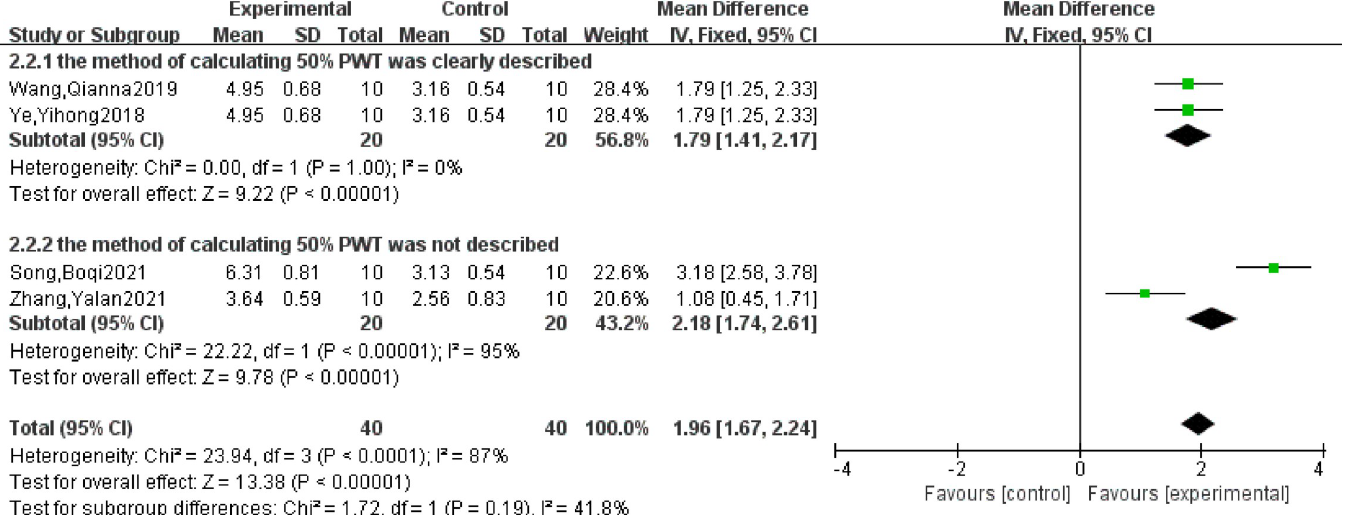
Fig 4. Subgroup analysis of